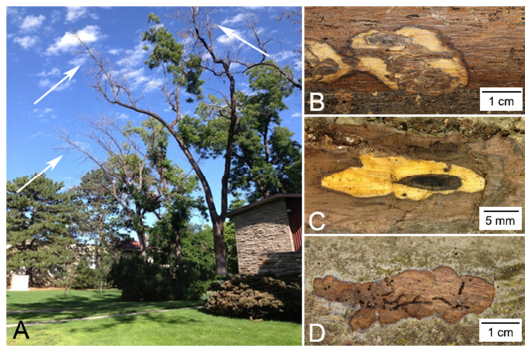
Figure 1. Thousand Cankers Disease symptoms, gallery formation, and canker development. Later stage crown and branch dieback symptoms of Thousand Cankers Disease on Juglans nigra trees (white arrows). Trees exhibit symptoms similar to drought, including flagging and yellowing of leaves, branch dieback, and canopy loss ( A ); Pityophthorus juglandis galleries and exit holes in the phloem of J. regia branch. Multiple coalescing cankers on J. hindsii have girdled the branch resulting in rapid tree mortality ( B ); Characteristic elliptical canker associated with Geosmithia morbida infection in J. nigra branch. The cankers are visible only after the outer bark is removed ( C ); Adult walnut twig beetles create entrance and emergence holes about the size of a pinhead (0.64–0.75 mm), with galleries approximately 2.5–5 cm long ( D